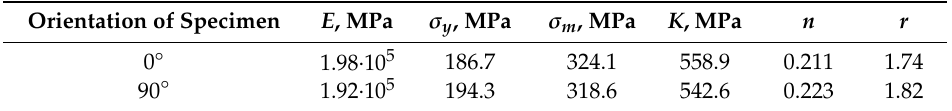
Table 1. Mechanical properties of the DC04 steel sheets 1